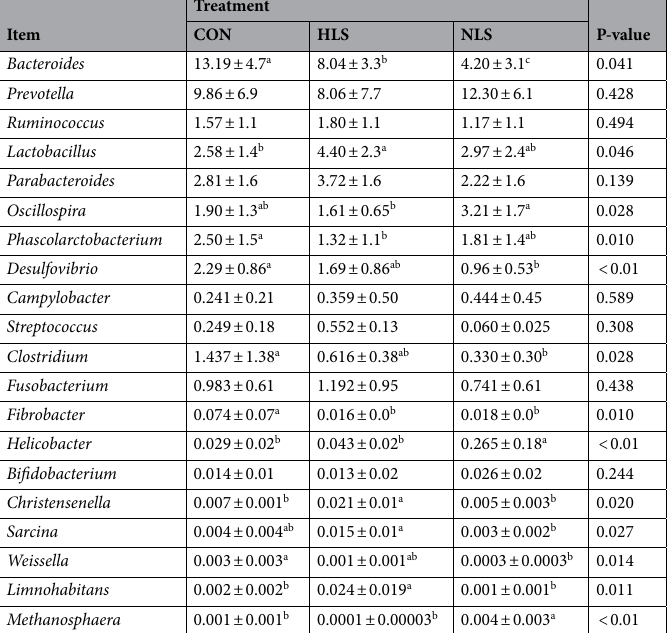
Table 2. Relative abundance of the fecal microbiota genera of three groups at weaning (d 21). CON, Control; HLS, Lactobacilus salivarius 144 isolated from fast-growing pig feces; NLS, L. salivarius 160 isolated from normal weight pig feces. a-b Means with different superscripts within rows are significantly different at P < 0.05.